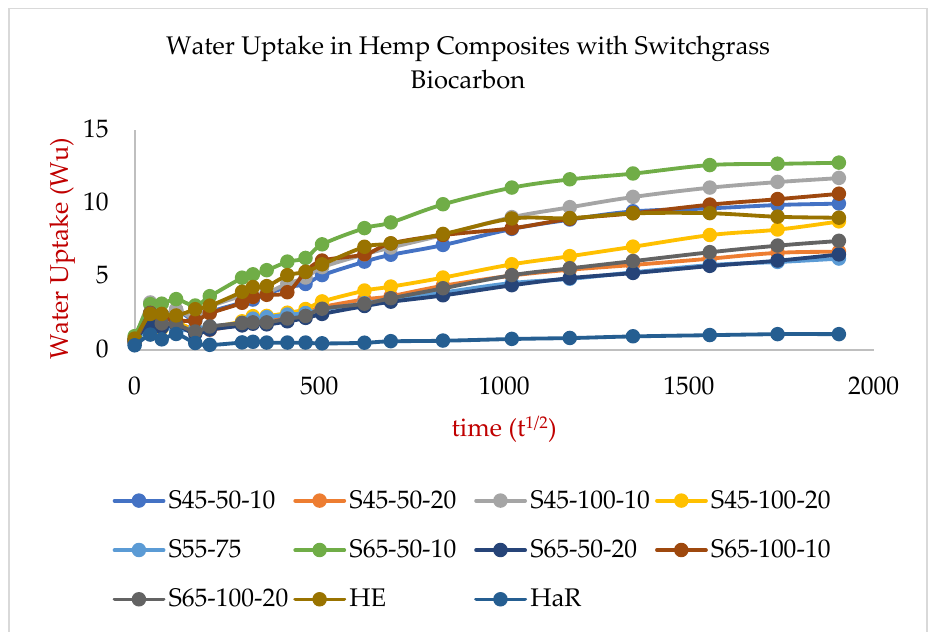
Figure 7. Water uptake nature of various switchgrass-biochar composites as a function of the square of time.